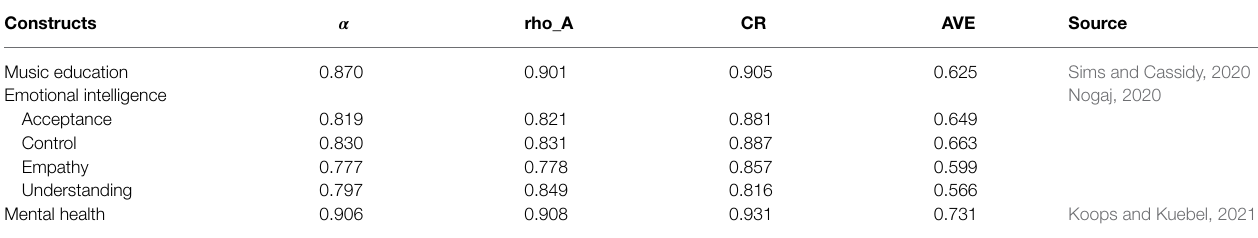
TABLE 1 | Measurement model.